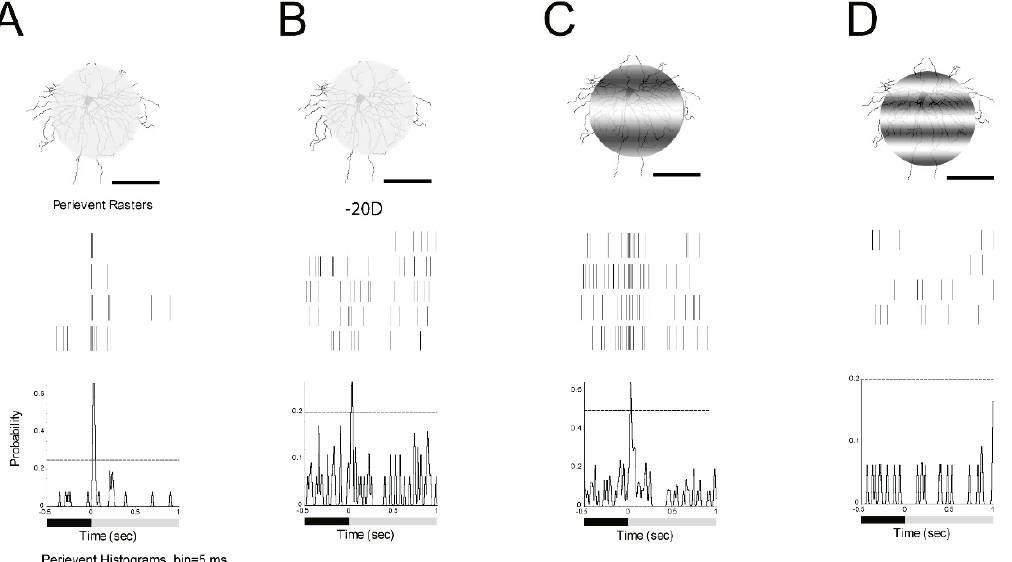
Figure 4. Defocused images and different spatial frequencies can both change the signaling of α - RGCs. A : ON α -RGC response to 1 s 125 µm, 0 cycles/degree light spot. Light stimulus (I = 1.665 × 10 5 Rh*/rod/sec). B : ON α -RGC response to 1 s 125 µm, 0 cycles/degree light spot while defocus